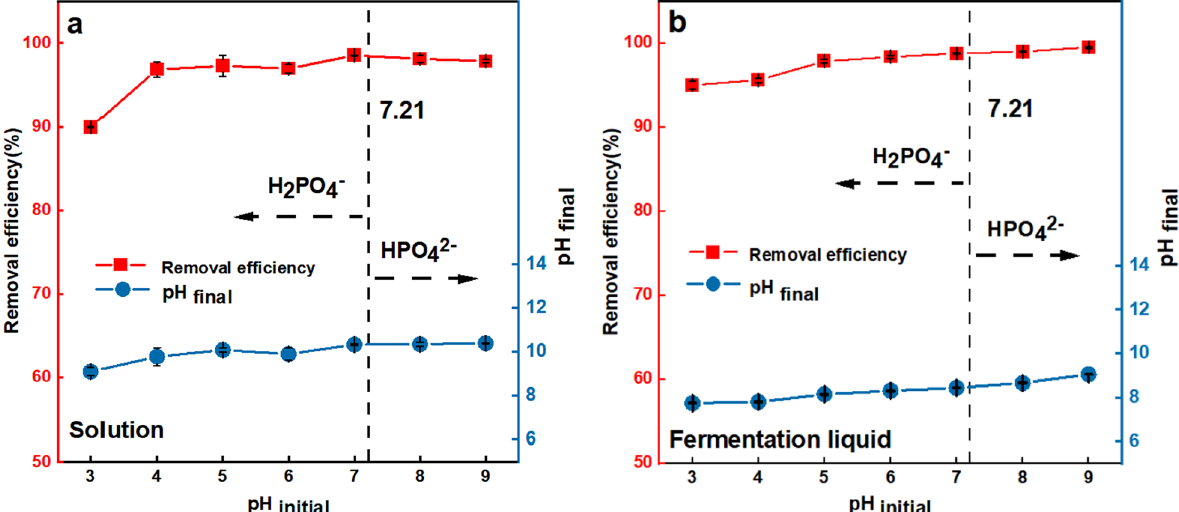
Fig. 3 Effect of initial pH on the removal of P from a synthetic solution; b kitchen waste fermentation